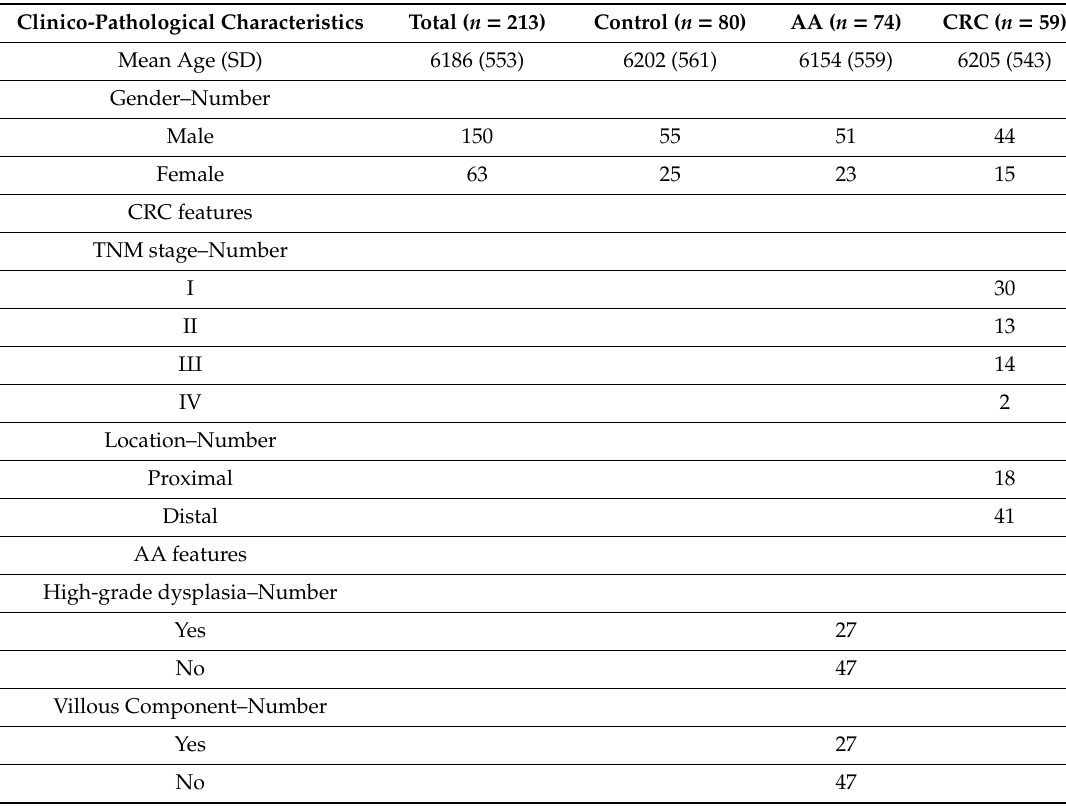
Figure 1. Schematic representation of the study. Two-hundred and sixty-four serum samples were collected from individuals positive to the faecal immunochemical test (FIT + ) and after colonoscopy were distributed in three groups: colorectal cancer (CRC), advanced adenomas (AA) and individuals with normal colonoscopy (controls). After serum haemolysis assessment and microRNA (miRNA) extraction and spike-in cel-miR-39 quantification, 51 samples were discarded from the final analysis. Table 1. Clinical features of the study subjects. AA: advanced adenomas, CRC: colorectal cancer, TNM: Tumour Nodes Metastasis classification , SD: standard deviation.